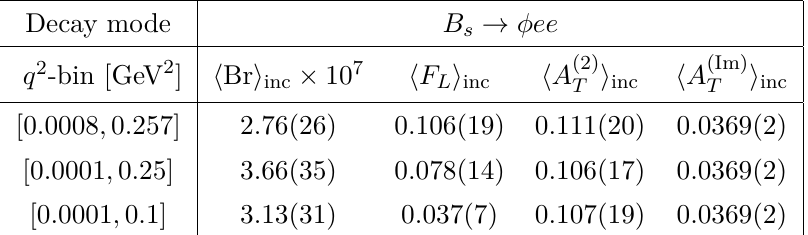
) and Br( B ) . s → φee s → φee